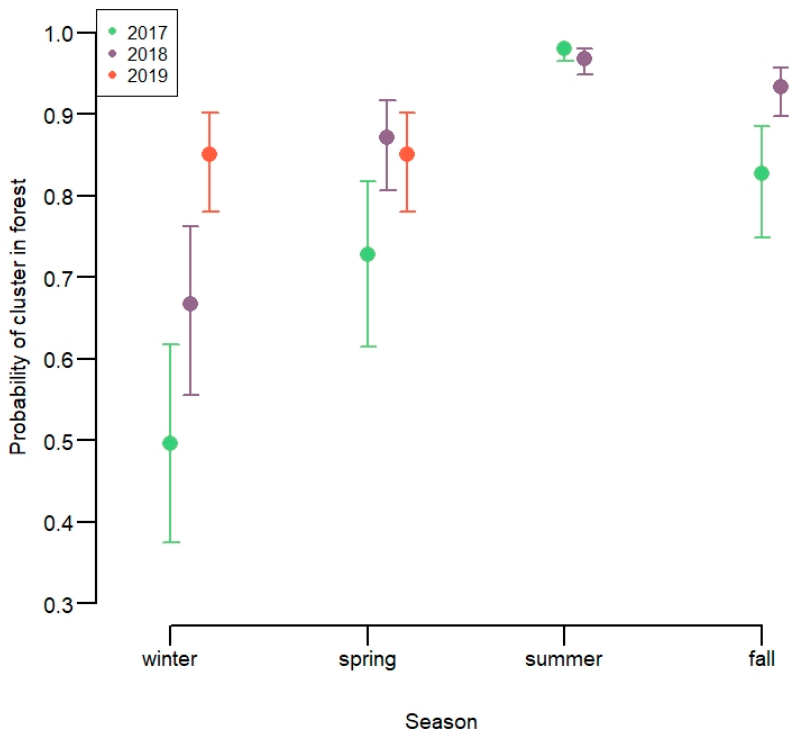
Figure 3. Proportion of clusters in forest compared to on agricultural fields of 13 GPS-marked red deer in Lærdal municipality, Norway. Number of spatial clusters . The average monthly number of spatial clusters per animal varied strongly from year to year, but less markedly across seasons (Figure 4, Tables S1 and S2). There were fewer clusters per animal per month in 2017 (150–200). In 2018, there were more clusters per animal per month in winter and spring (250–350), compared to summer and fall (200–250). In 2019, the average number of clusters was intermediate. The average number of spatial clusters per month and individual increased with increasing snow depth only in 2018 (Table S4), which is likely also the cause of more winter clusters this year.